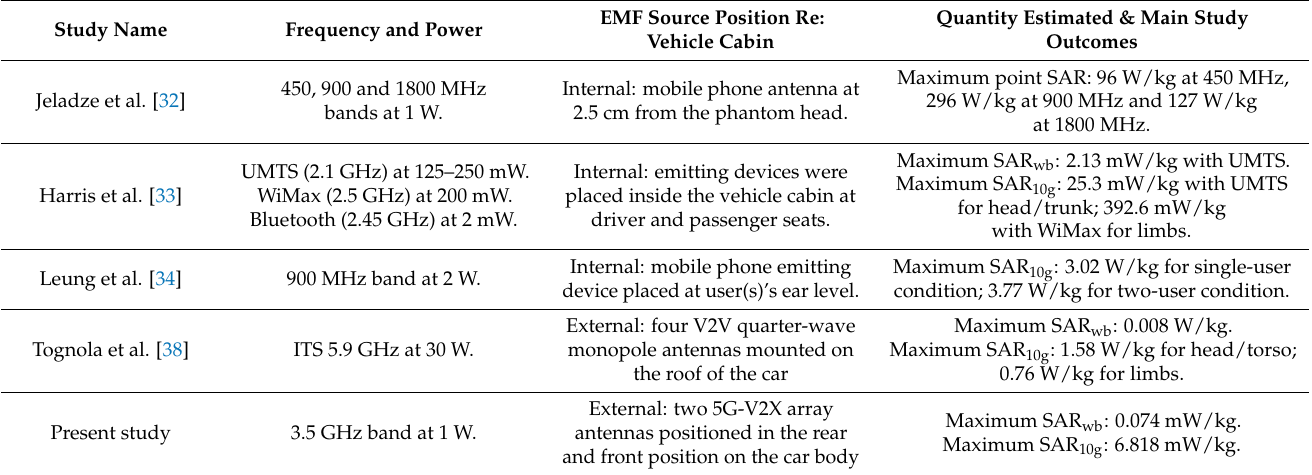
Table 5. SAR assessment in the connected